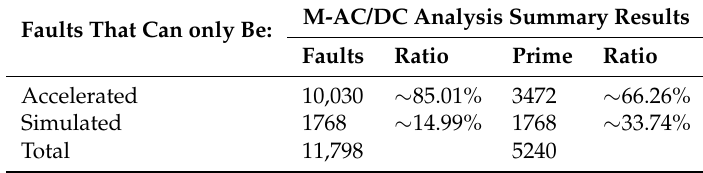
Table 7. Exception (EX) fault candidates that are suitable for acceleration. Faults That Can only